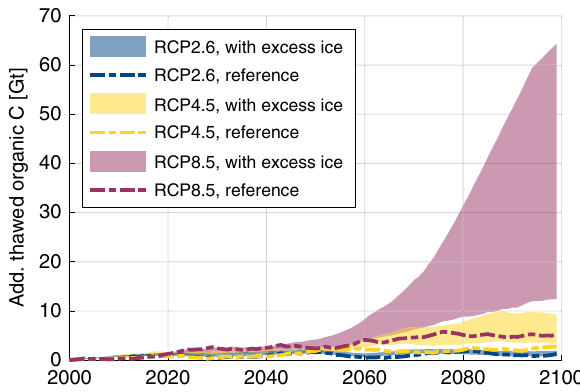
Fig. 4 Projection of thaw-affected organic carbon stocks. The estimates were obtained by scaling the simulation results using representative stratigraphies and the total areal extent of each landscape type within the northeast Siberian lowlands (see “ Methods ” ). For each warming scenario, the indicated ranges correspond to 11-year running means of the annual maximum of thawed organic carbon under contrasting hydrological conditions. The reference runs without excess ice re fl ect the simplistic representation of permafrost in